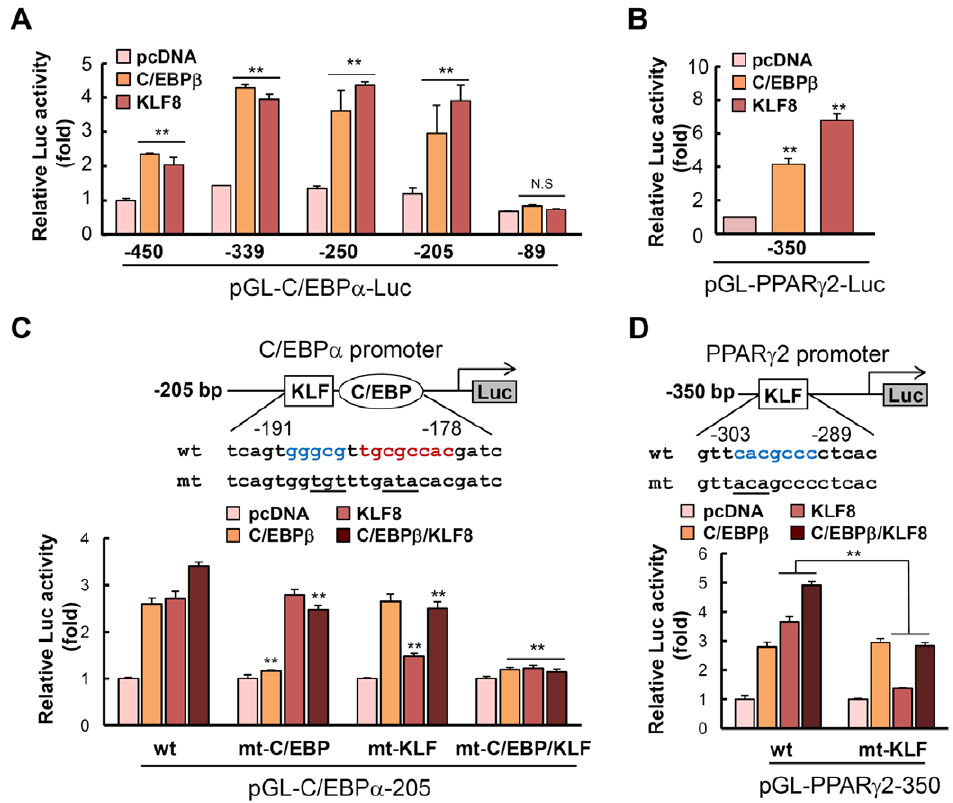
Figure 4. KLF8 regulates C/EBP a and PPAR c 2 promoters to induce transcription. (A) A series of C/EBP a promoter constructs cloned into the pGL3-Basic vector was used in this study. NIH3T3 cells were transfected with the luciferase constructs using Lipofectamine, and the luciferase activities were determined after 2 days. The plasmids pcDNA3.0, pCMV-C/EBP b , or pCMV-KLF8-FLAG were cotransfected. (B) Similarly, the PPAR c 2 promoter ( 2 350 counted from transcription initiation site) was investigated by luciferase assay. (C) Mutation analysis of the C/EBP a promoter was performed. The 2 205 construct was used for the site directed mutagenesis in order to introduce KLF and/or C/EBP regulatory element between 2 191 and 2 178 region. The KLF8 binding site was indicated in blue, whereas the C/EBP site was marked in red. The mutated region was underlined. NIH3T3 cells were transfected with these constructs along with KLF8 and/or C/EBP b overexpression plasmids. (D) Mutation analysis of the PPAR c 2 promoter was performed. The KLF site was mutated by site-specific mutagenesis, and the resulting construct was analysed by luciferase assay. Data represent the mean 6 SD. ** P , 0.01.